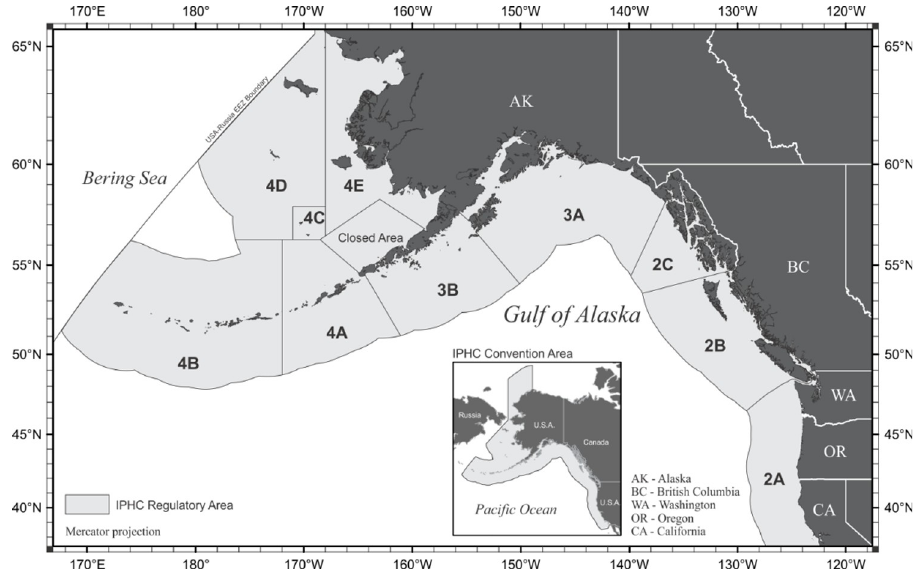
Fig 1. IPHC regulatory areas (courtesy of